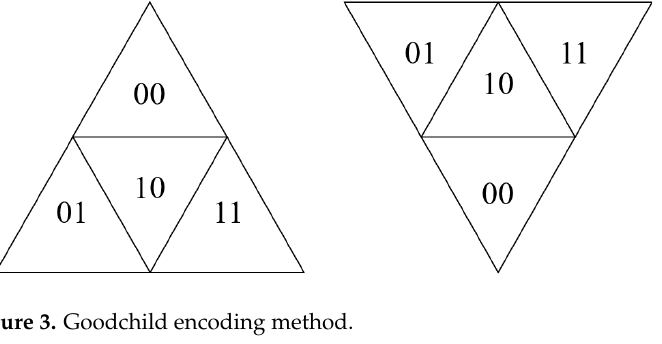
Figure 3. Goodchild encoding method.